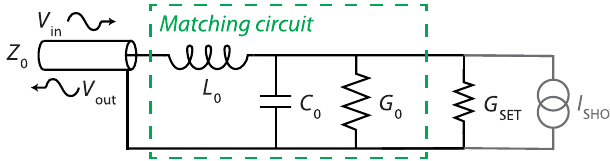
FIG. 4. rf SET matching circuit schematic. We represent the , which is connected to a transmission SET by conductance G SET line of characteristic impedance Z 0 via an L -match filter circuit consisting of inductance L 0 , capacitance C 0 , and parasitic dissipation represented by conductance G 0 . The current source at right represents the shot-noise contribution of the SET, I SHOT